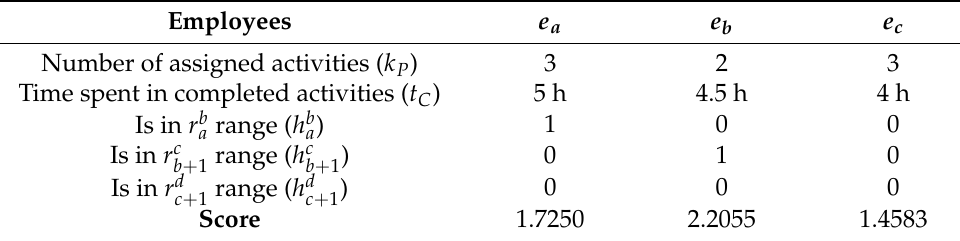
Table 1. Variables table with computed score. Employees e a Number of assigned activities ( k P